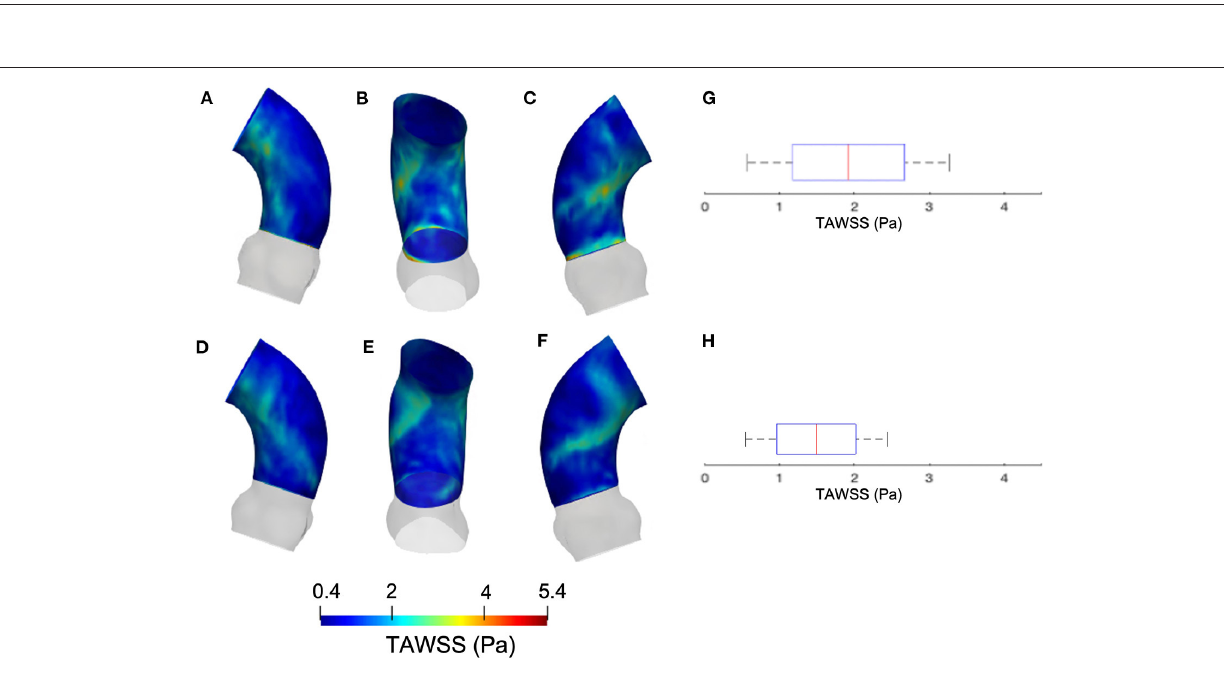
FIGURE 8 | Contour map of the TAWSS at p 0 [min: 0.4 Pa, avg: 2.3 Pa, max: 3.6 Pa] (A–C) and p 4 [min: 0.3 Pa, avg: 1.2 Pa, max: 2.5 Pa] (D–F) . Box plots of the TAWSS are reported for p 0 (G) and p 4 (H)